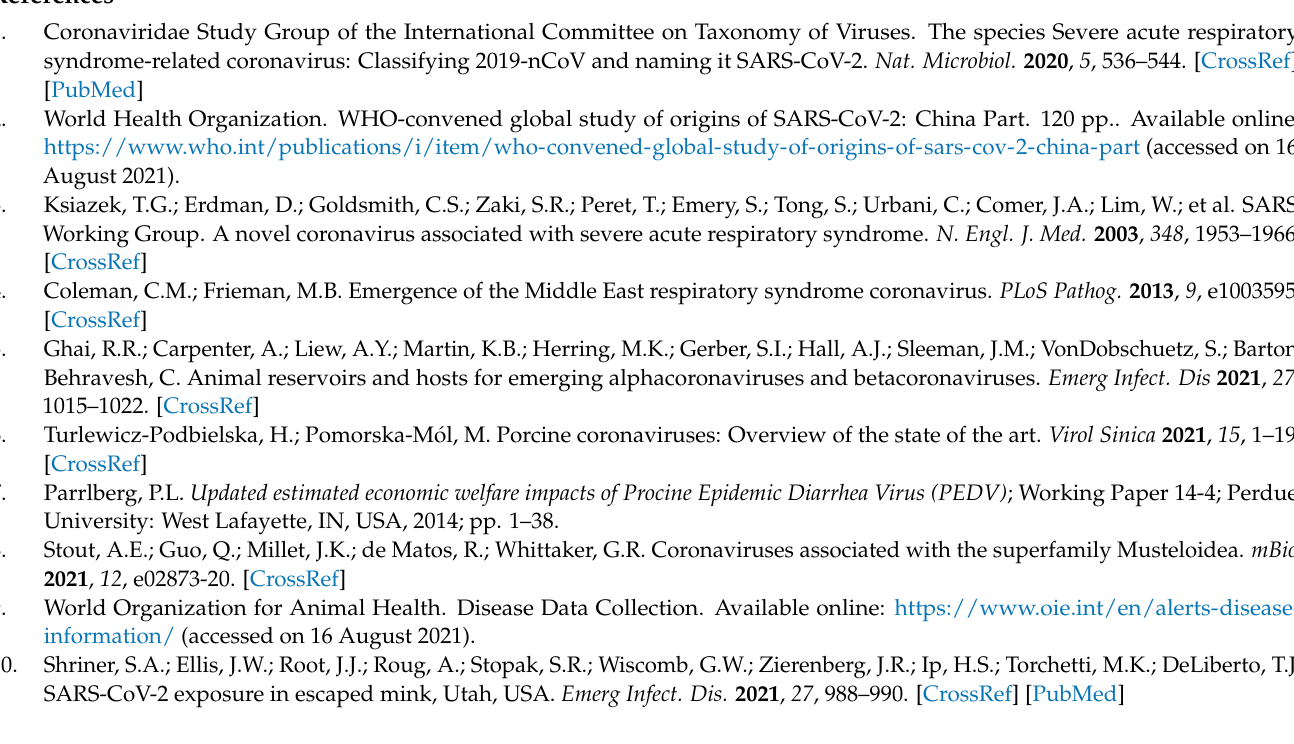
Utah. Table S1: List of animals and tissues sampled and RT-PCR test results. Table S2: Summary of coronavirus test